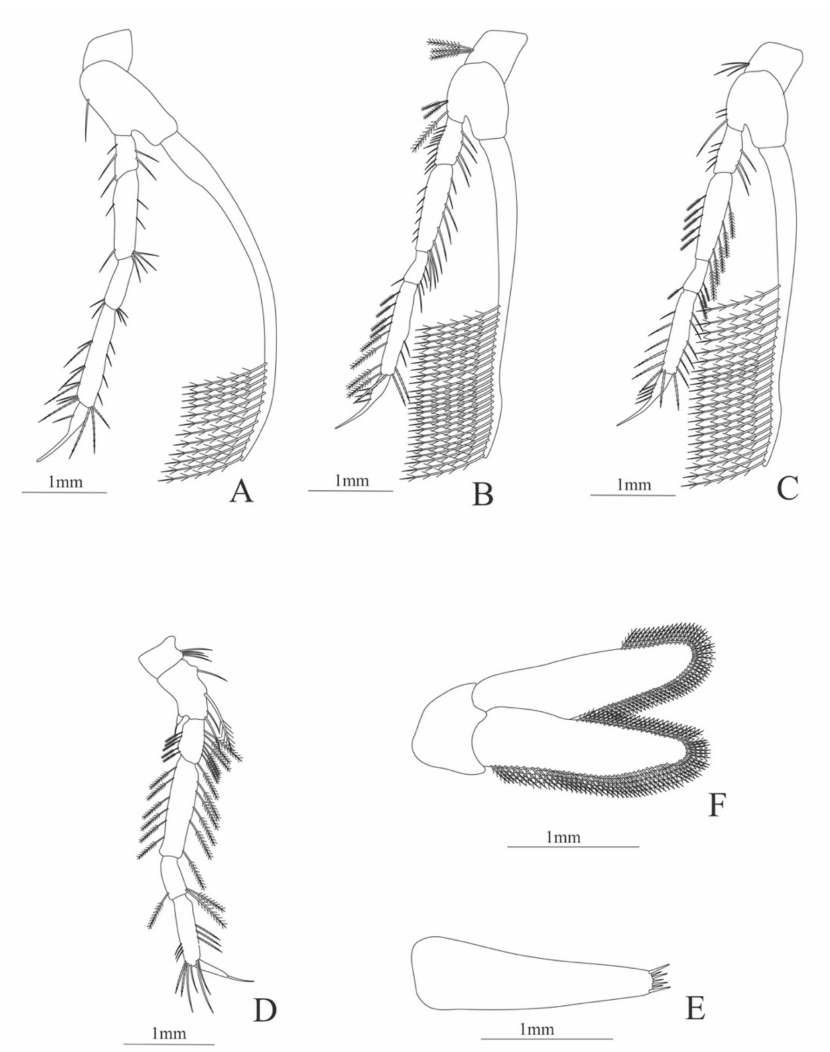
Figure 11. Eugonatonotus crassus : ( A ) second pereopod; ( B ) third pereopod; ( C ) fourth pereopod; ( D ) first pereopod; ( E ) uropods; ( F )